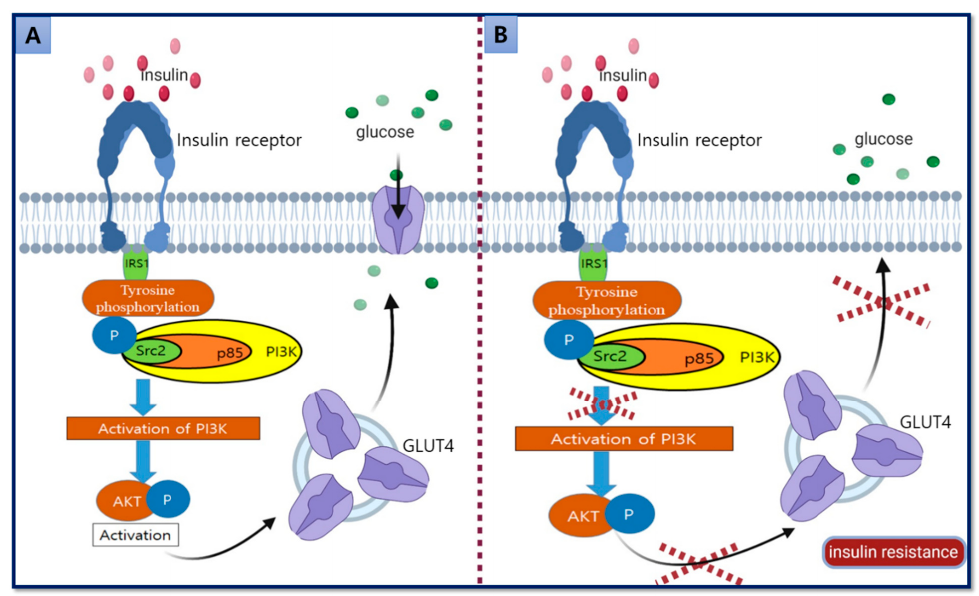
Figure 1. Glucose uptake mechanism via insulin-mediated translocation of GLUT4. ( A ) Insulin binds to the insulin receptor, activating autophosphorylation and PI3K, which activates AKT followed by translocation of vesicles containing GLUT4 from the intracellular compartment to the surface membrane. GLUT4 inserts into the membrane and triggers the uptake of glucose. ( B ) Disturbance in the activation of PI3K and AKT pathways disrupts the GLUT4 translocation that eventually results in the development of insulin resistance (IR) [arrow shows the next step of the process and cross shows the disruption of the process].